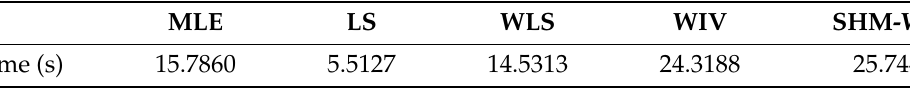
Table 4. Total simulation run time in MATLAB.